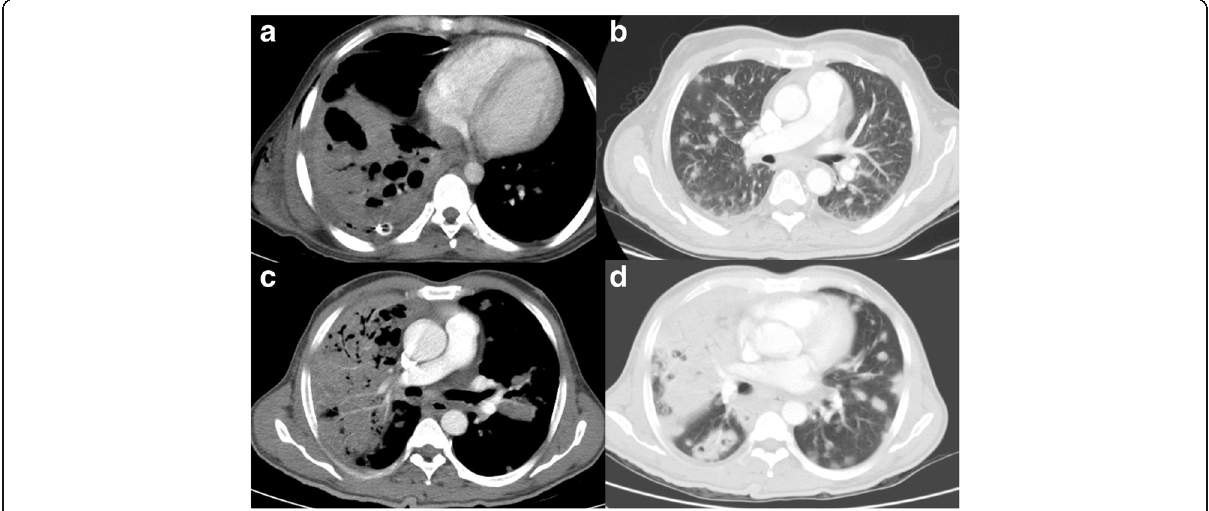
Fig. 1 Lung melioidosis. a Forty-three-year-old male with a 1-month history of fever, respiratory symptoms, ( a ) axial CT thorax showed large consolidation with cavitation, intercostal drainage tube with residual mild right sided effusion, small chest wall collection. b Sixty-five-year-old male, known diabetic, presented with fever and low oxygen saturation at the time of admission, axial CT performed depicts multiple nodules in the lungs. This patient succumbed to death on day 6 of admission. Axial CT performed for a 49-year-old male presented with a 7-day history of fever, sputum culture grew Burkholderia pseudomallei, blood culture grew Pseudomonas aeruginosa , CT thorax in ( c ) mediastinal and ( d ) lung windows show large, multisegmental consolidation with cavitations and multiple nodules. Despite starting treatment for both organisms and being on ventilator support, he died on day 5 of